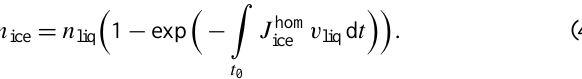
Fig. 2. A schematic description of the different pathways included in ZOMM. The dashed arrows depict processes which were rep- resented in previous model versions; the solid arrows show those added to the model for this study. T dew denotes the dew point, i.e. the temperature at which water saturation is reached. The tempera- tures indicated for T dew , T frost and T NAT are approximate, based on typical polar stratospheric conditions. Foreign nuclei are indicated by the black triangles. While here the focus is on the heterogeneous nucleation of NAT (thick black arrow), the heterogeneous nucle- ation of ice (thin solid black arrows) is discussed in a companion paper (Engel et al., 2013). The heterogeneous nucleation of NAT occurs in STS aerosol droplets which contain a foreign nucleus (tri- angle surrounded by circle on the upper right of the figure), after the nucleation of NAT and as the air parcel continues to cool, a supercooled binary solution (SBS) coating, consisting of H 2 O and H 2 SO 4 , is present on the NAT